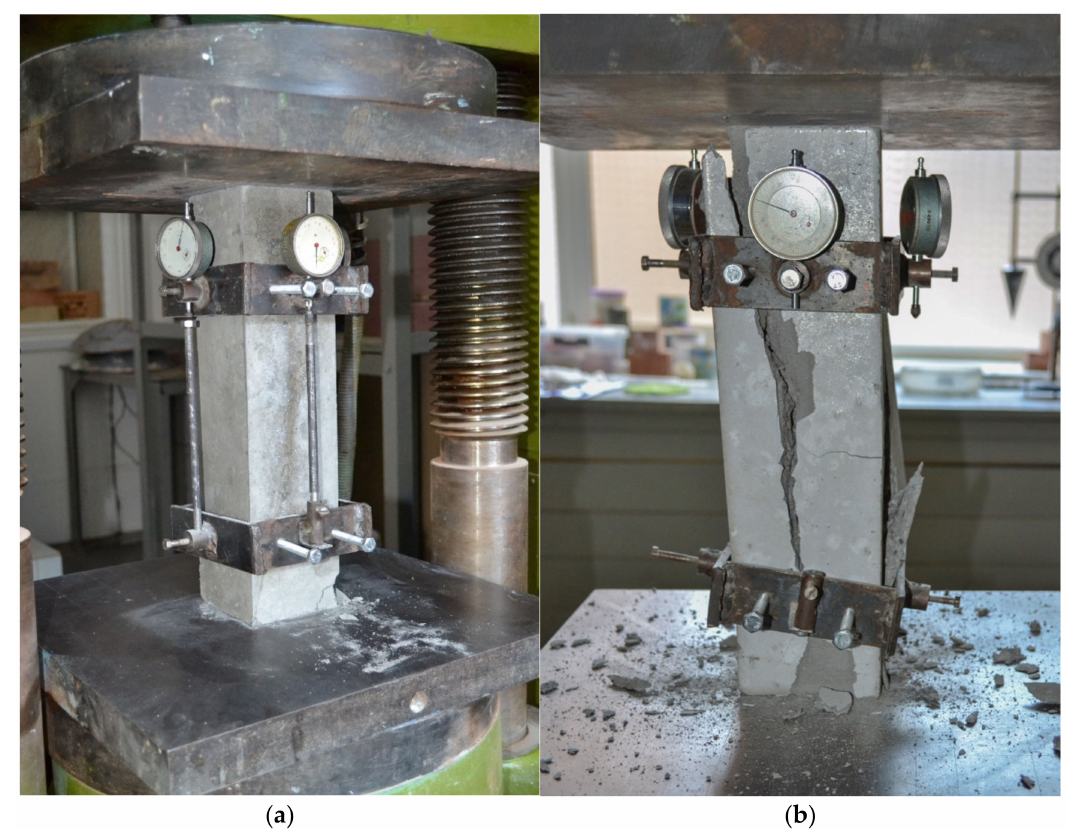
Figure 2. Photo of strain measurement of the prism sample under axial compression ( a ); sample after collapse ( b ). Compression, axial tensile, and flexural tensile tests were carried out in accordance with the requirements of GOST 10180 “Concretes. Methods for strength determination using reference specimens” [36]. Axial compression tests were carried out in